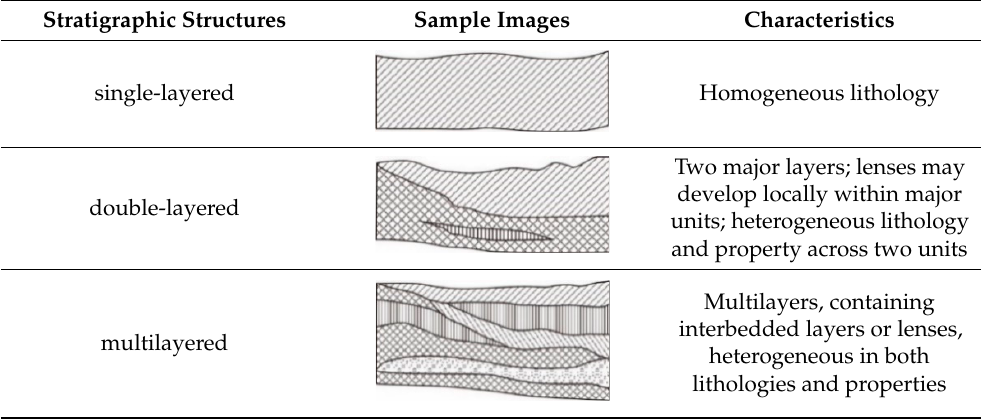
Table 2. Stratigraphic structure is identified as one of the UUS evaluation indicators (adapted after Refs. [59,60]).